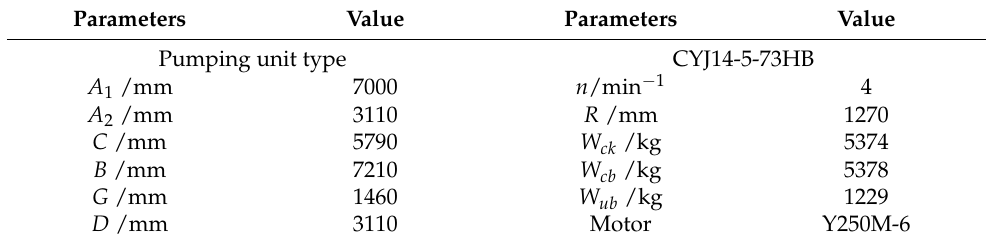
Table 1. The main parameters of the test